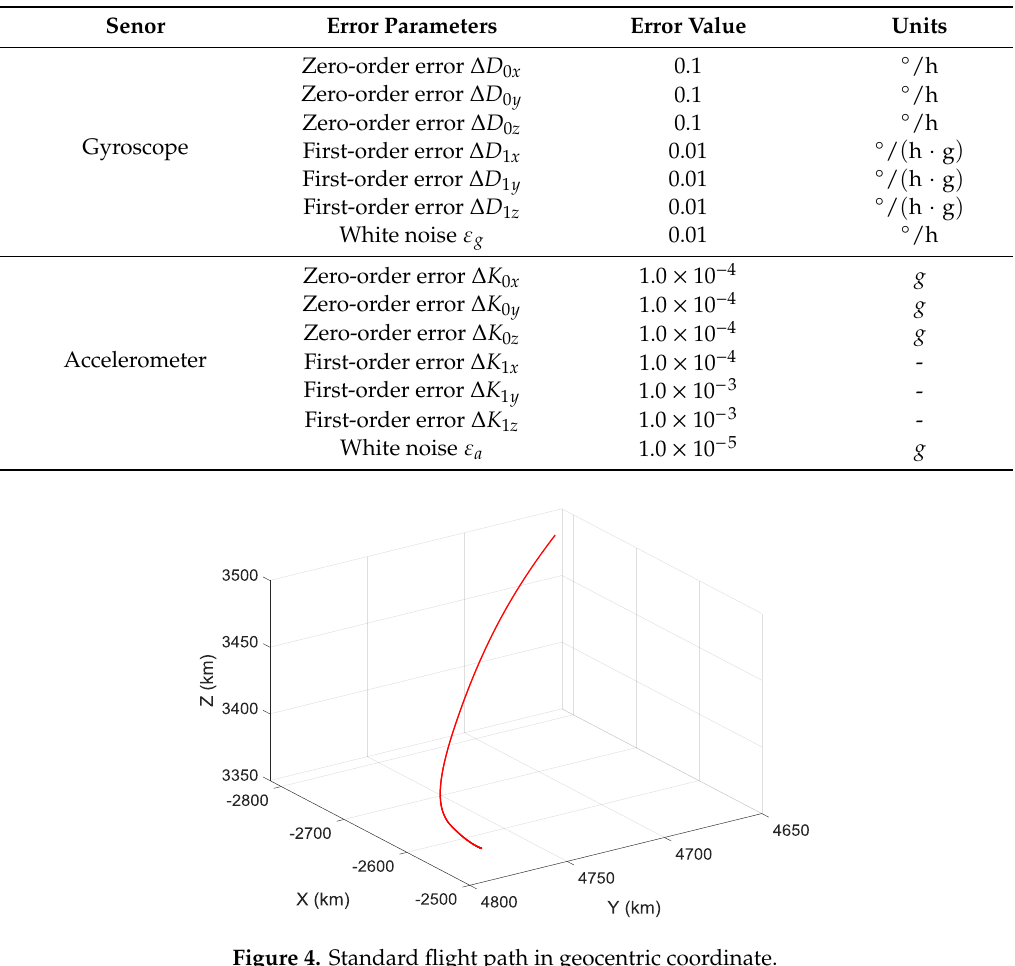
Table 1. Instrument error parameters of IMU.